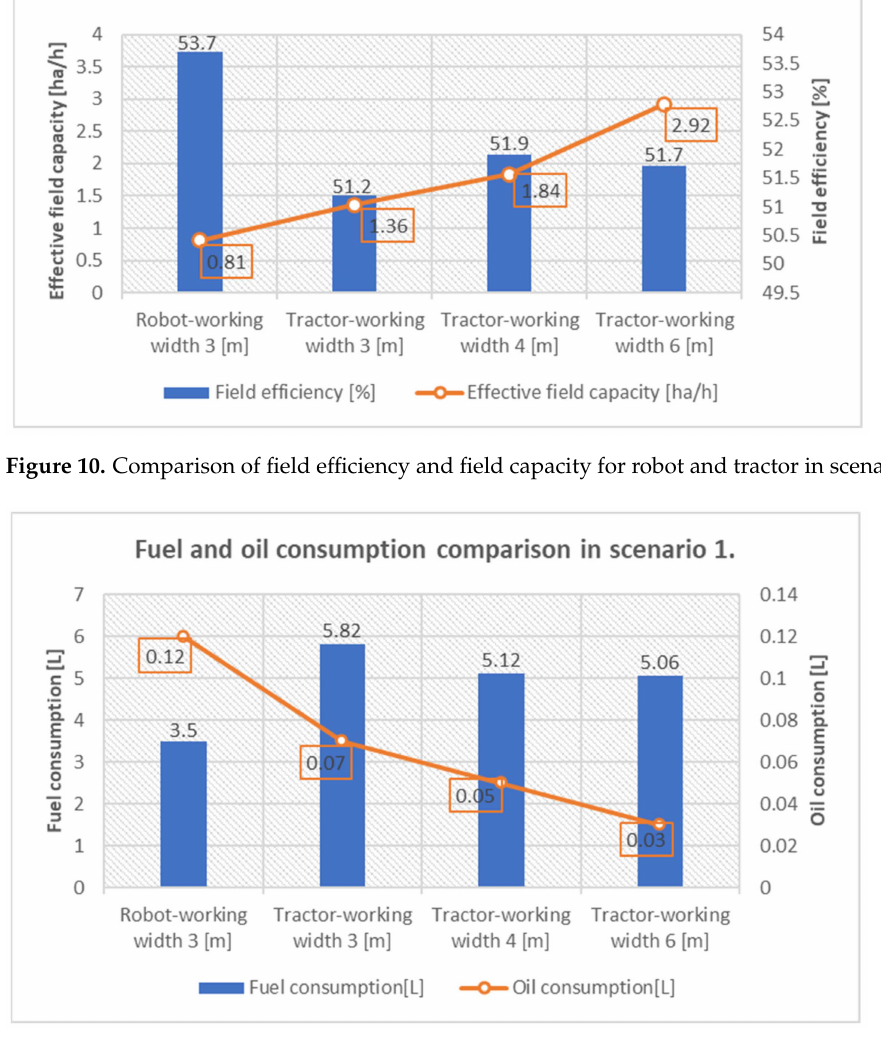
Figure 11. Comparison of fuel and oil consumption for robot and tractor in scenario